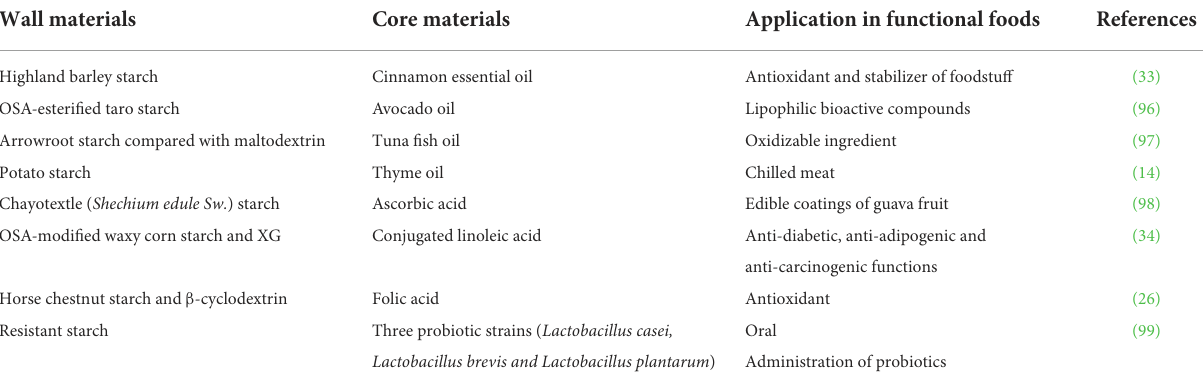
TABLE 3 Sources of wall and core materials and application of starch-based nano-microcapsules in functional